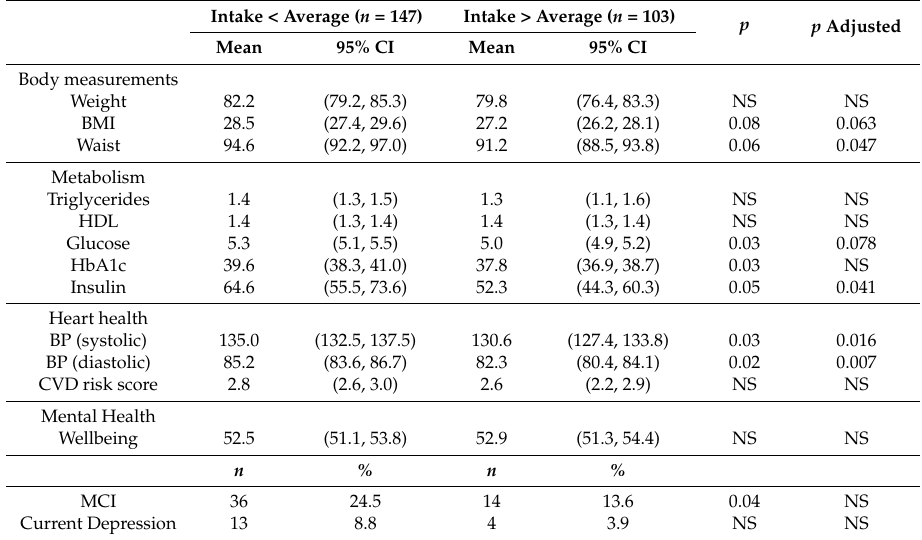
Table 6. Significant dietary vitamin C effects based on average intake for body measures, metabolic health and heart